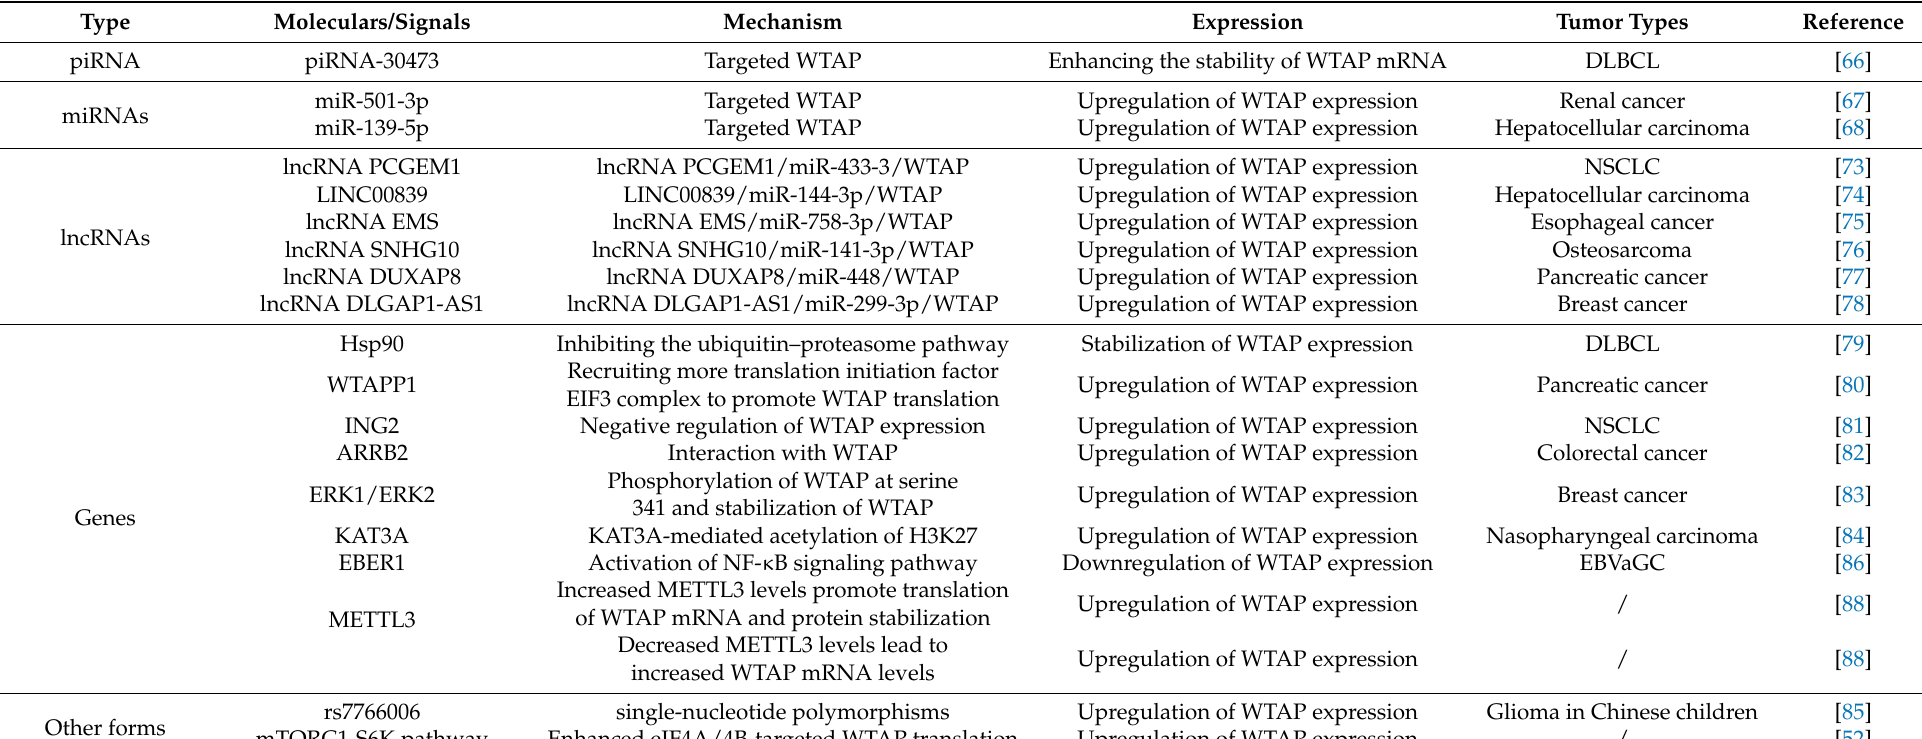
Table 1. Regulation of WTAP